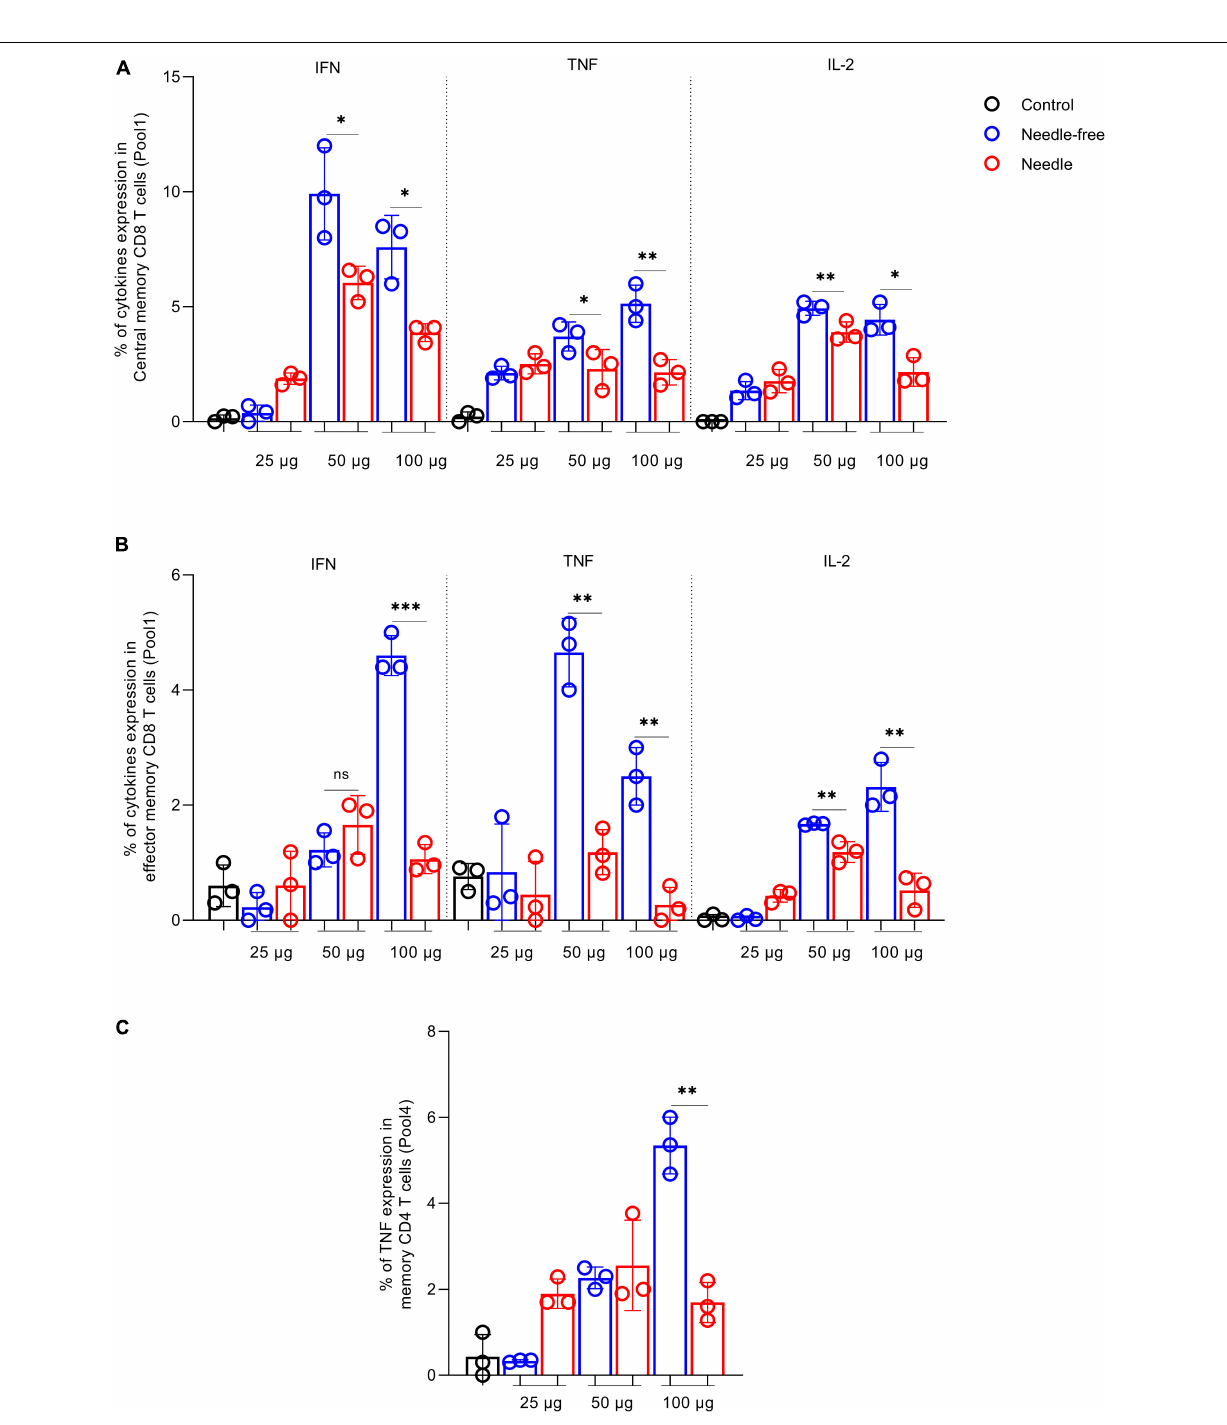
Frontiers in Microbiology |